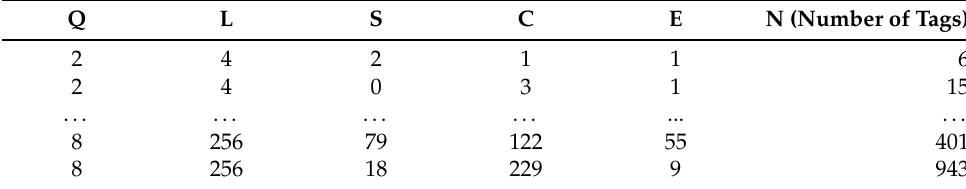
Table 2. Snapshot of the obtained